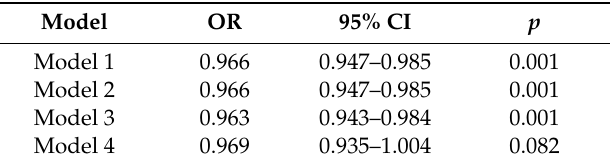
Table 4. Odds ratio (OR) and 95% confidence interval (CI) of serum chemerin with liver cirrhosis at 3 months after therapy. Model 1: adjusted for age and BMI; Model 2: adjusted for age, BMI, and gender; Model 3: adjusted for age, BMI, gender, alanine aminotransferase, and aspartate aminotransferase; Model 4: adjusted for age, BMI, gender, alanine aminotransferase, aspartate aminotransferase, and MELD